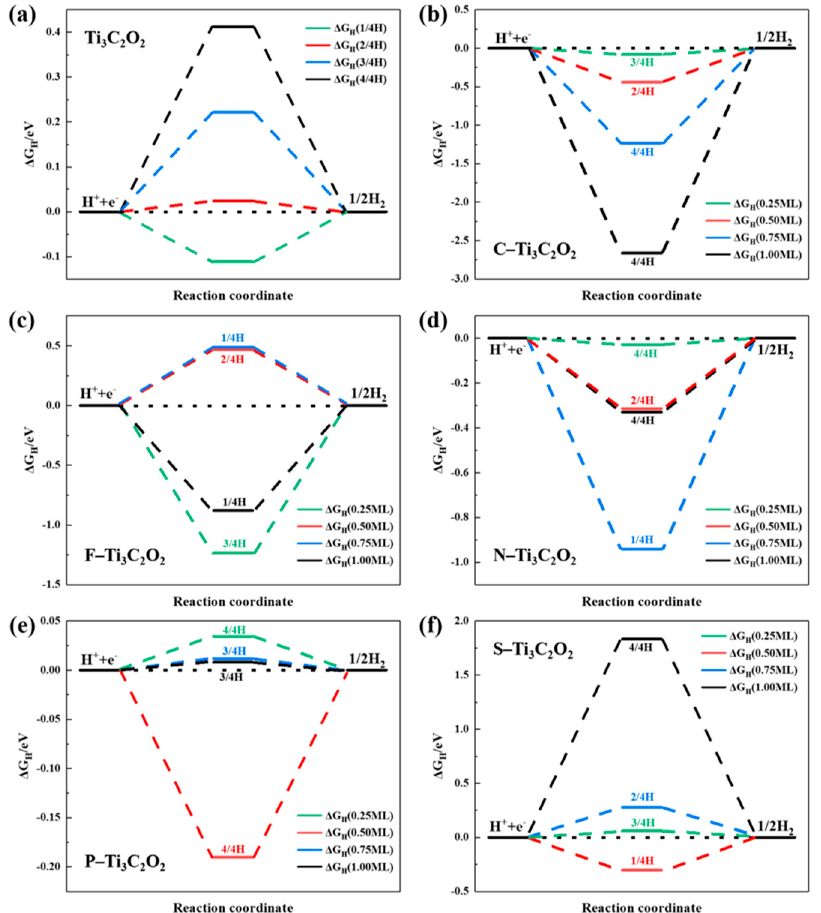
Figure 4. The hydrogen adsorption free energy( ∆ G H ) of Ti 3 C 2 O 2 and nonmetal doping Ti 3 C 2 O 2 . ( a ) Ti 3 C 2 O 2 , ( b ) C doping Ti 3 C 2 O 2 , ( c ) F doping Ti 3 C 2 O 2 , ( d ) N doping Ti 3 C 2 O 2 , ( e ) P doping Ti 3 C 2 O 2 , ( f ) S doping Ti 3 C 2 O 2 .